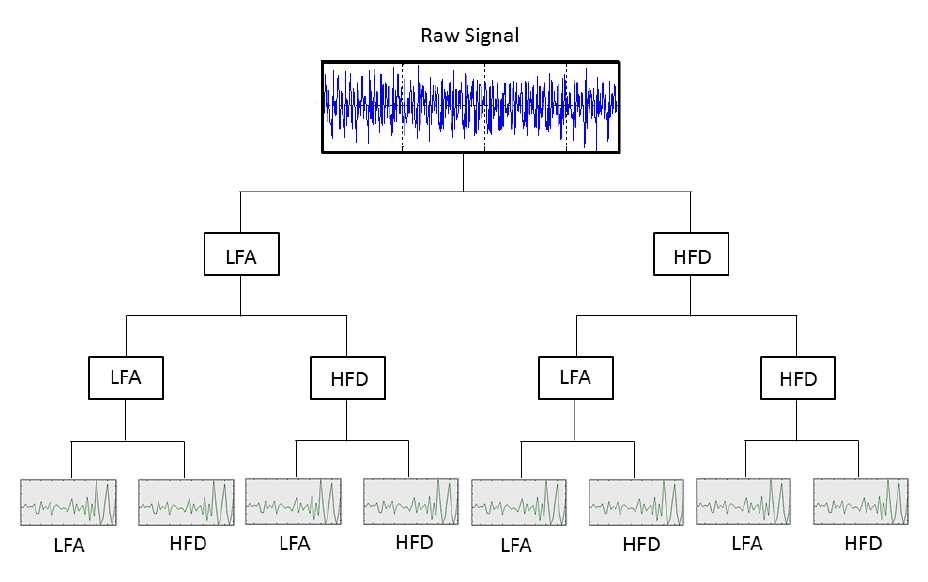
Figure 5. The wavelet packet